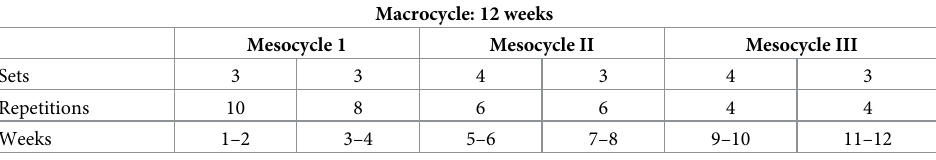
Table 2. Periodization model of the high-intensity resistance training